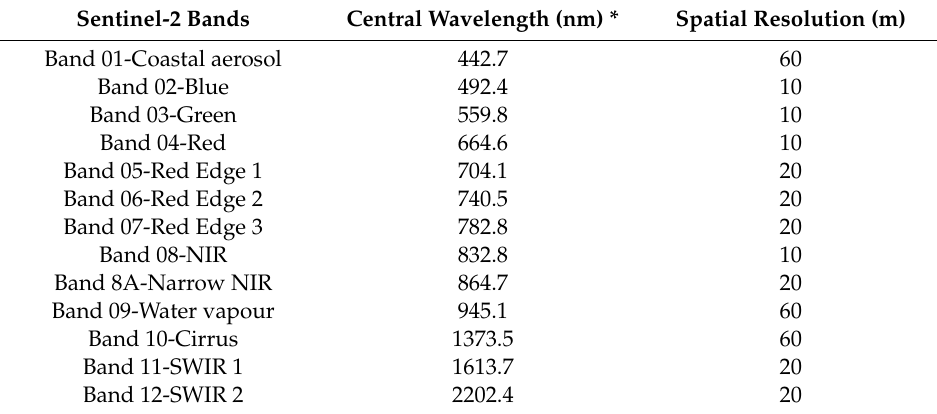
Table 3. Sentinel-2 Level 2A bands. NIR, near-infrared; SWIR, shortwave